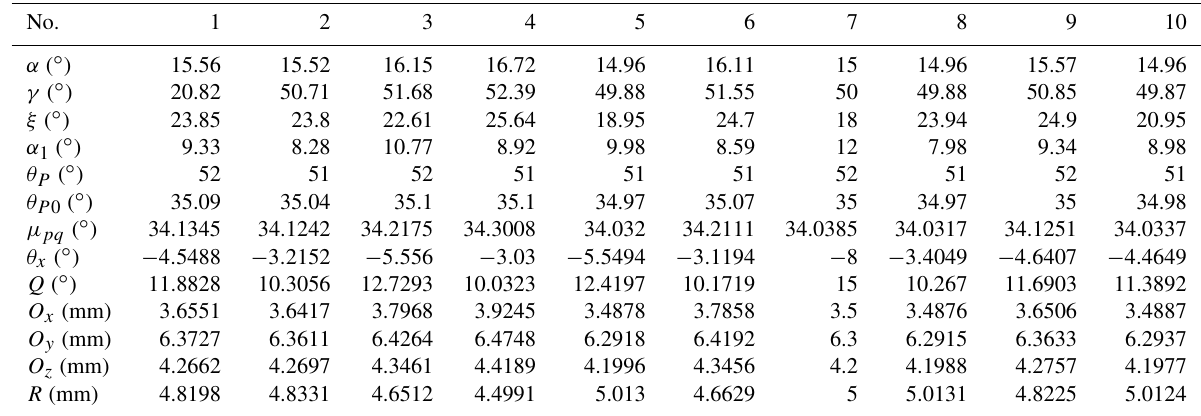
Table 7. Dimension and arrangement parameters.